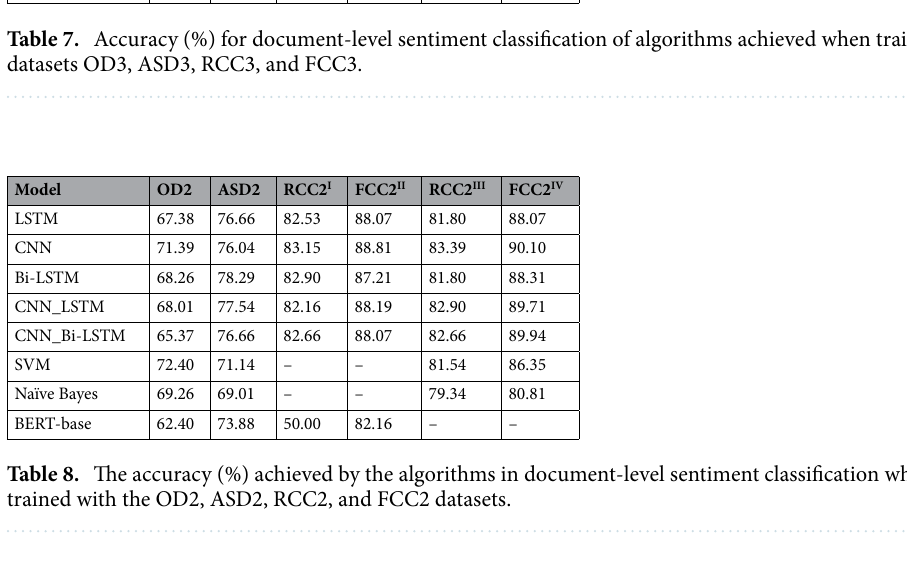
Table 7. Accuracy (%) for document-level sentiment classification of algorithms achieved when trained with datasets OD3, ASD3, RCC3, and FCC3.